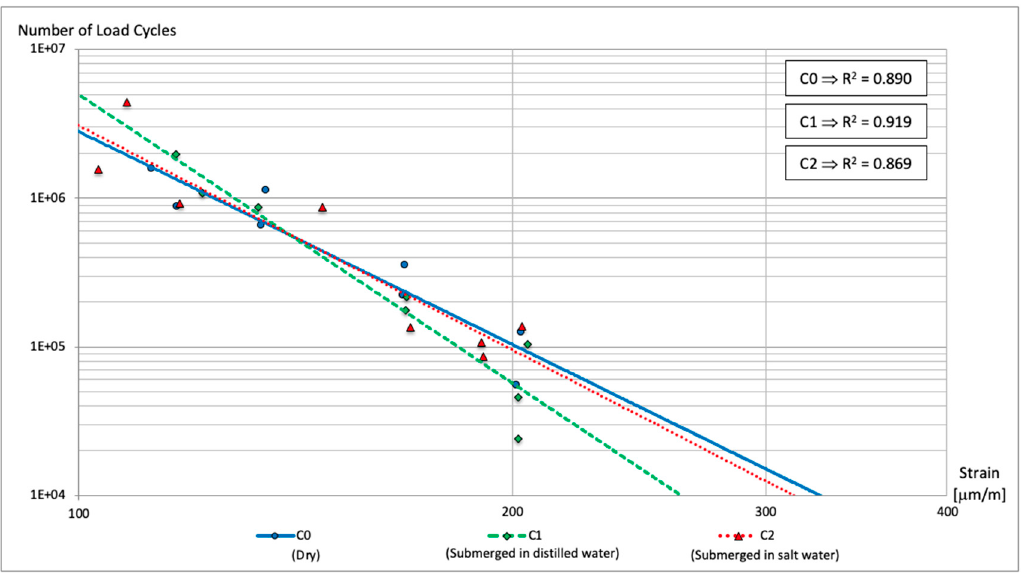
Figure 6. Fatigue test: specimens subjected to one of year outside storage.